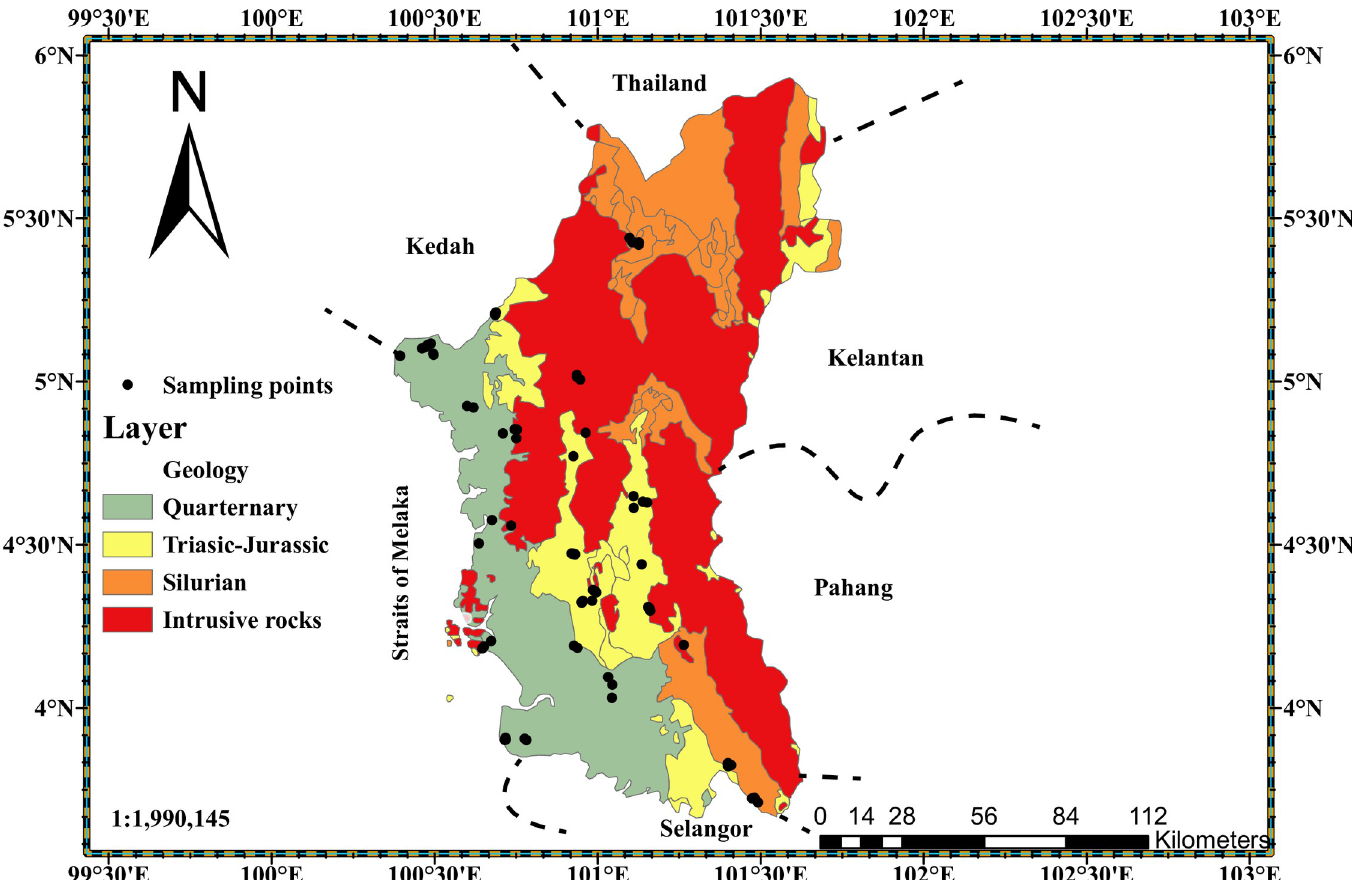
Fig 1. Geological map of Perak state (digitized from geological map of Peninsular Malaysia 1985 using Arc GIS Pro software).